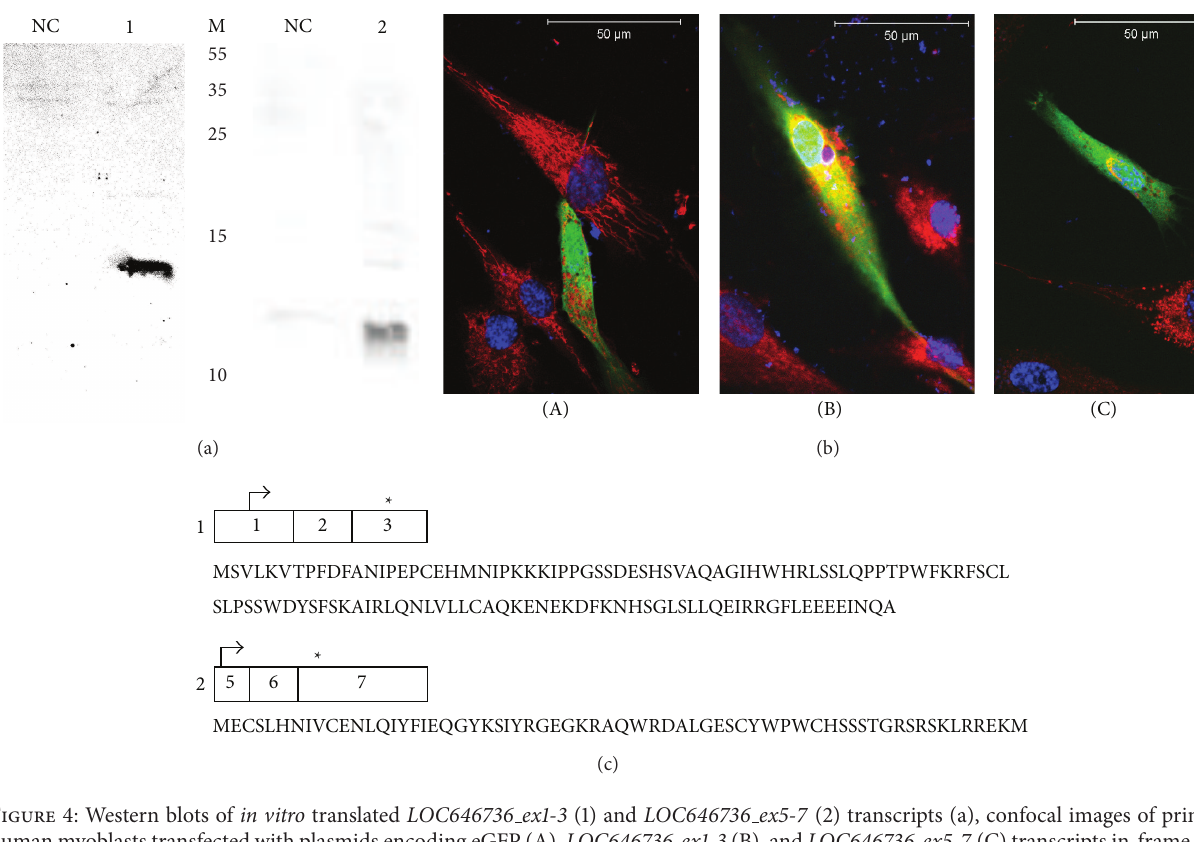
Figure 4: Western blots of in vitro translated LOC646736 ex1 - 3 (1) and LOC646736 ex5 - 7 (2) transcripts (a), confocal images of primary human myoblasts transfected with plasmids encoding eGFP (A), LOC646736 ex1 - 3 (B), and LOC646736 ex5 - 7 (C) transcripts in-frame with eGFP (b), and amino acid sequences encoded by LOC646736 ex1 - 3 and LOC646736 ex5 - 7 transcripts (c). NC, negative control; M, molecular weights in kDa; in B, cells were stained with MitoTracker and DAPI; in C, * indicates stop